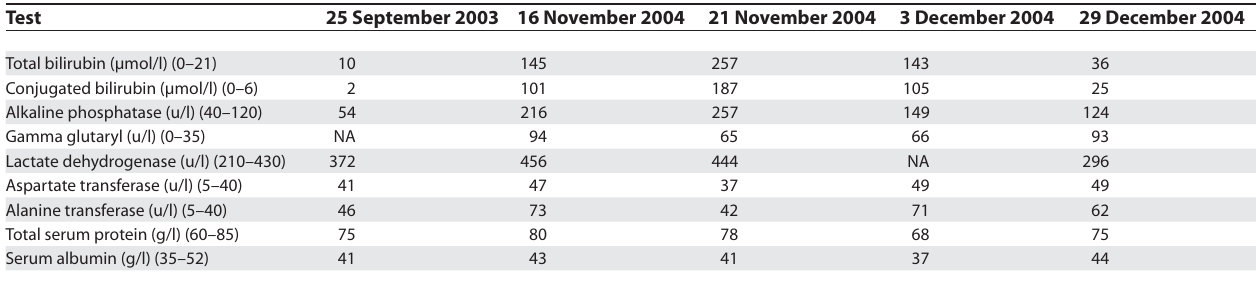
Table 2. Serial Liver Function Test Results